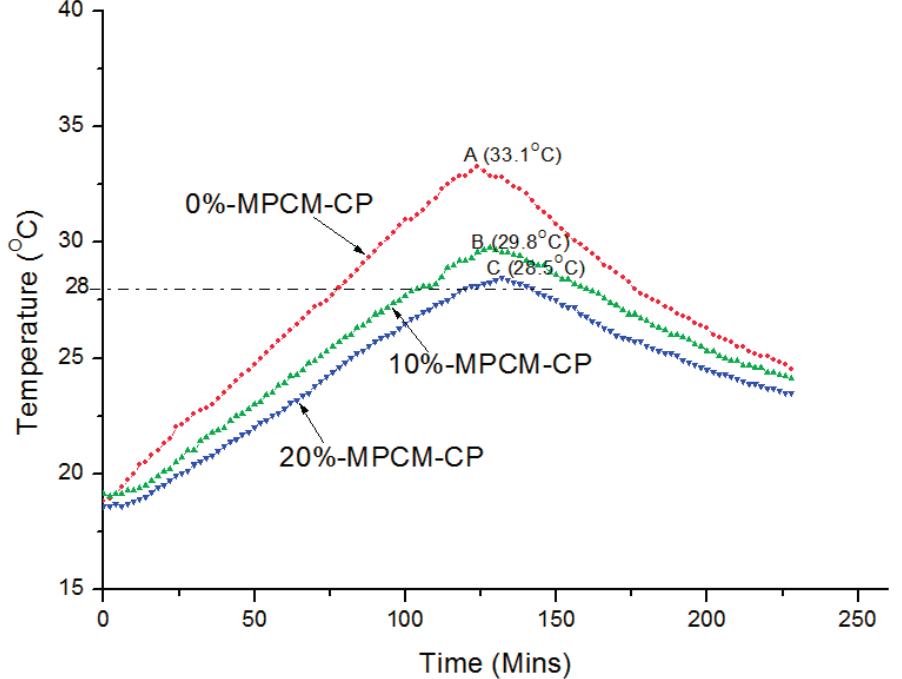
Figure 3. Thermal performance comparison between control and different MPCM-CPs with 0.5%